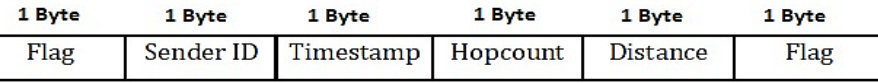
Figure 4. INFO Message Format.